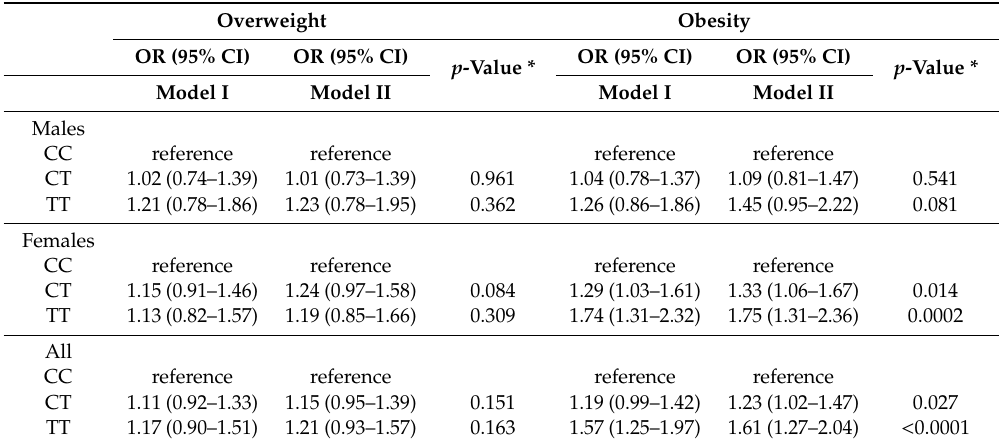
Table 5. Association between the TAS2R38 rs10246939 genotype and the risk of being overweight and obese in males and